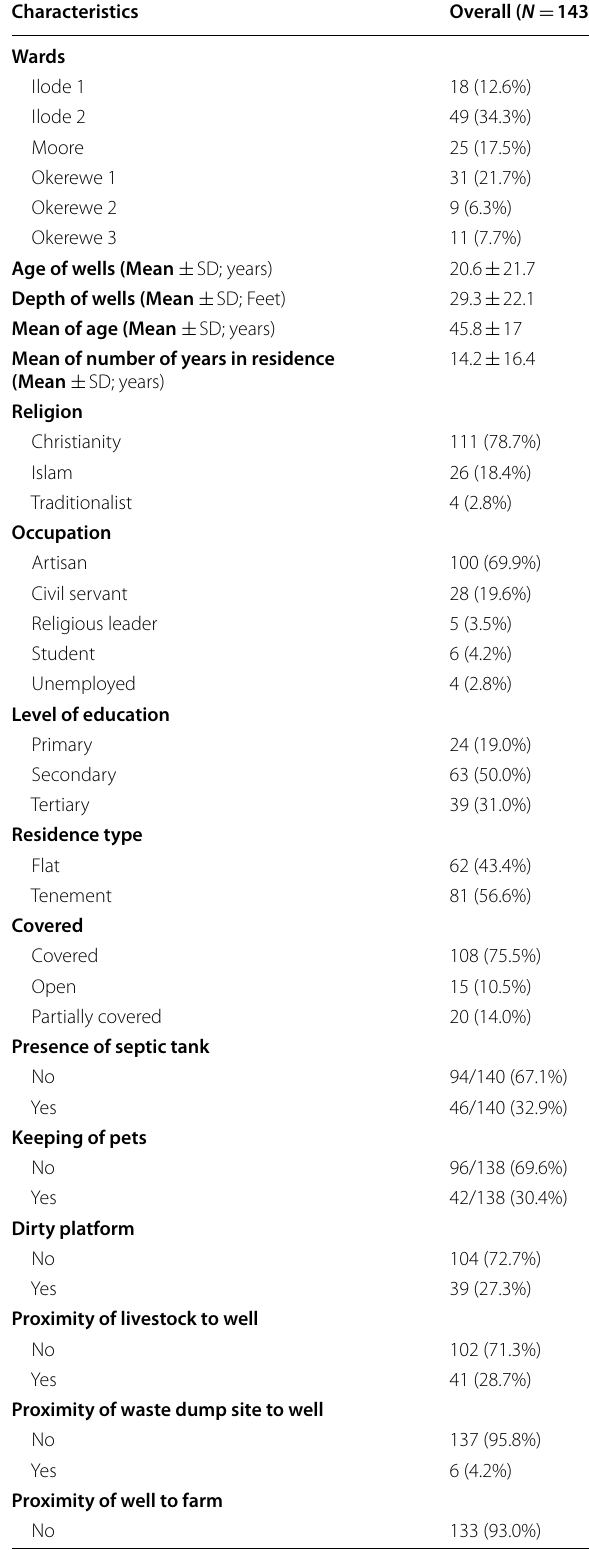
Table 2 Baseline characteristics of wells and owners